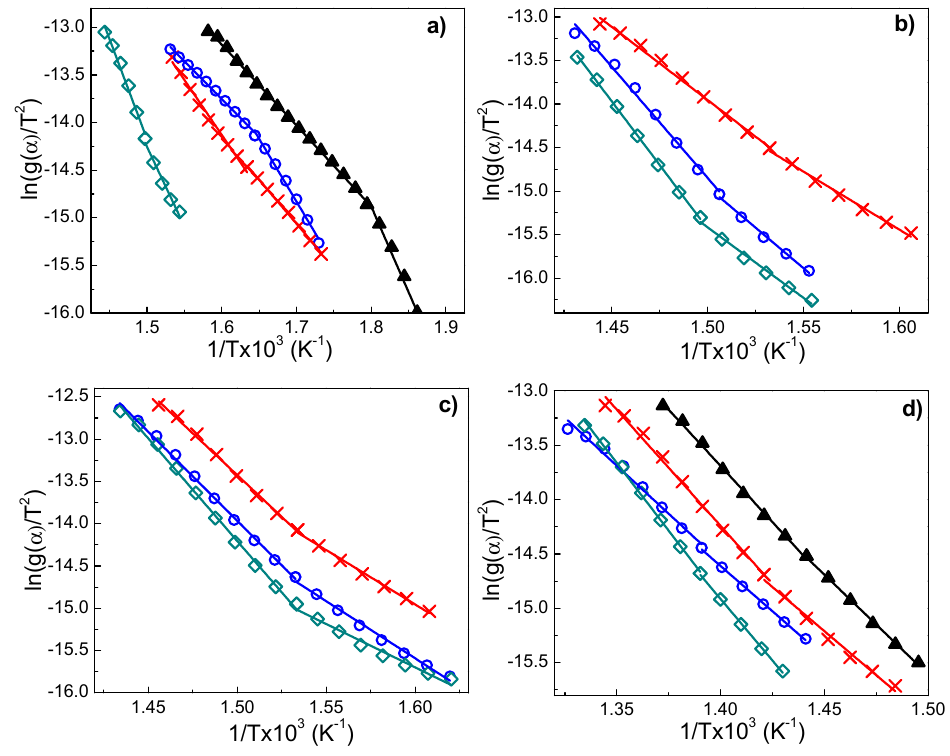
(cid:19) (cid:18) (cid:3034)(cid:4666)(cid:3080)) g ( α ) (cid:4673) vs. 1/ T for ( a ) PS/MgAl-AOL (10), ( b ) PS/2MgZnAl-AAC (15), ( c ) Figure 14. Plot of 𝑙𝑛 (cid:4672) Figure 14. Plot of ln vs. 1 / T for ( a ) PS / MgAl-AOL (10), ( b ) PS / 2MgZnAl-AAC (15), ( c ) (cid:3021) (cid:3118) T 2 PS/2MgZnAl-AOL (15), ( d ) PS/Mg2ZnAl-AAC(15) at ▲ 𝛽 = 5 °C/min, × 𝛽 = 10 °C/min, ○ 𝛽 = PS / 2MgZnAl-AOL (15), ( d ) PS / Mg2ZnAl-AAC(15) at (cid:78) β = 5 ◦ C / min, × β = 10 ◦ C / min, ◦ C / min and ♦ β = 30 ◦ C / min. 20 °C/min and ◊ 𝛽 = 30 °C/min. Table 9. Kinetic parameters obtained using the Coats–Redfern